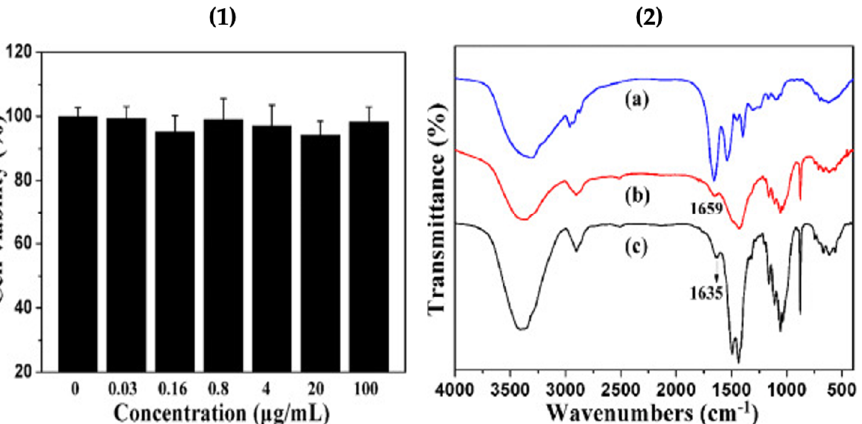
Figure 6. ( 1 ) Cytotoxicity tests of the cellulose/vaterite nanocomposites, and ( 2 ) FTIR spectra of pure Hb ( a ) and the cellulose/vaterite nanocomposites after ( b ) and before ( c ) Hb adsorption. This Figure is adapted with permission from [17].